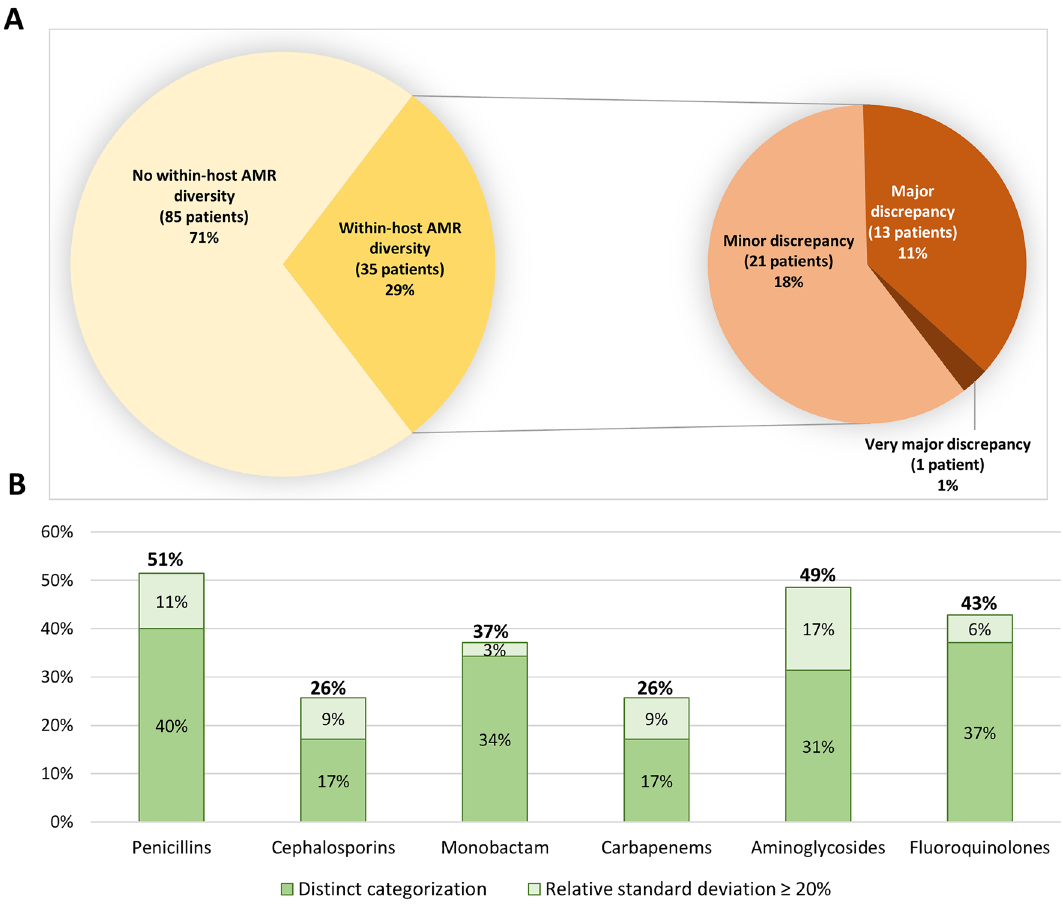
Figure 3. Within-host AMR diversity. ( A ) Number and percent of patients with within-host antimicrobial resistance (AMR) diversity, including minor, major, or very major discrepancies. ( B ) Percent of patients with within-host AMR diversity according to antibiotic classes. Overall diversity rates are presented for each antimicrobial group in bold, above the bar chart. Percentage of AMR diversity due to distinct categorization (susceptible, intermediate or resistant) or relative standard deviation ≥ 20% of the inhibition zone diameters are indicated for each antimicrobial group inside the bar